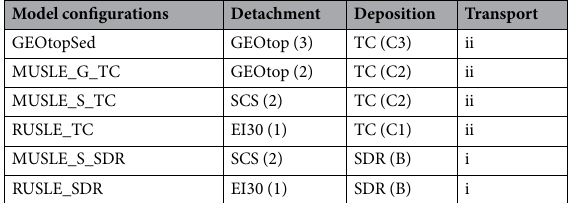
Table 3. Selected model configurations and corresponding process representations. Representation type (see Table 1 for more details) is shown in